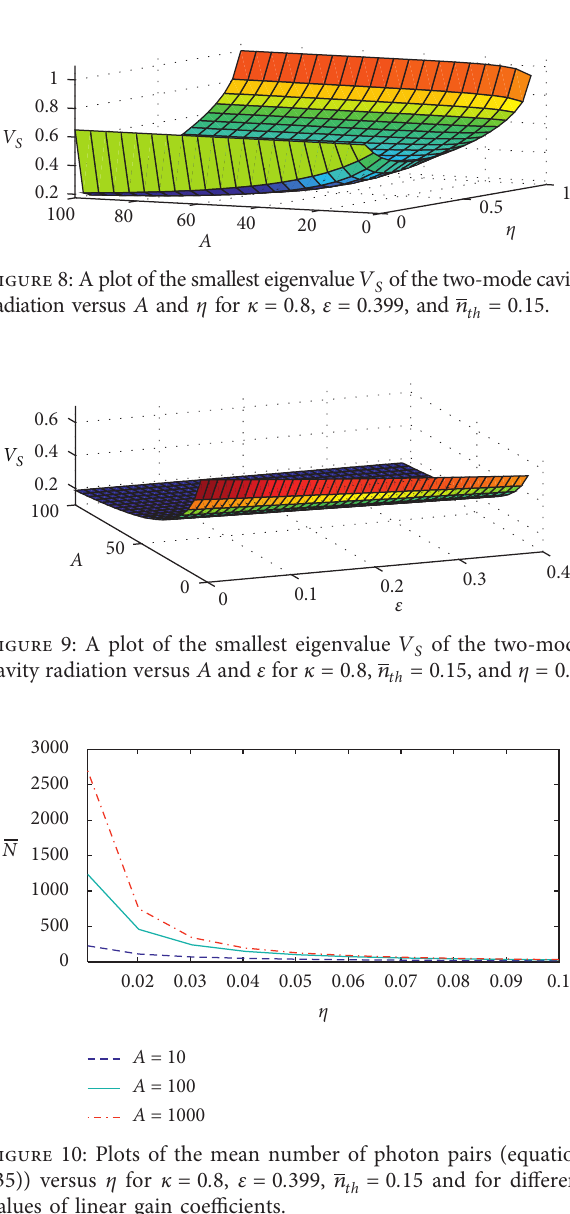
Figure 7: Plots of the smallest eigenvalue V n � 0 . 15, S versus η for th κ � 0 . 8, ε � 0 . 399 and for different values of n th .